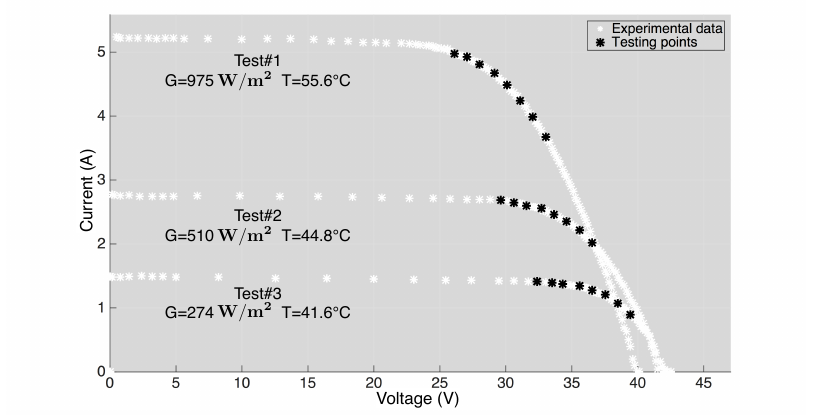
Figure 4. Experimental I-V curves of the Sunowe Solar SF125x125-72-m(l) PV panel, in different environmental conditions.